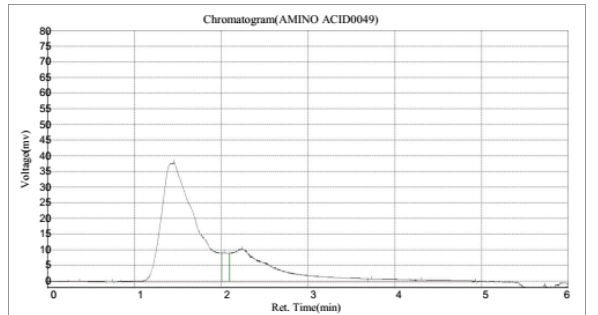
High-performance liquid chromatogram of yellow variety of tiger nut monosaccharide.